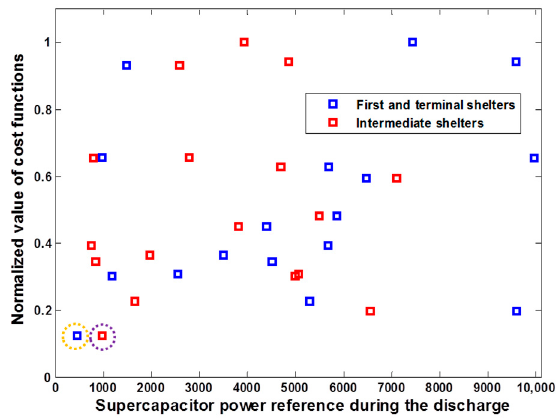
Figure 9. Power available for the control of SC in the discharge process. Optimal values: Yellow circle (first and terminal shelter), Purple circle (intermediate shelters).